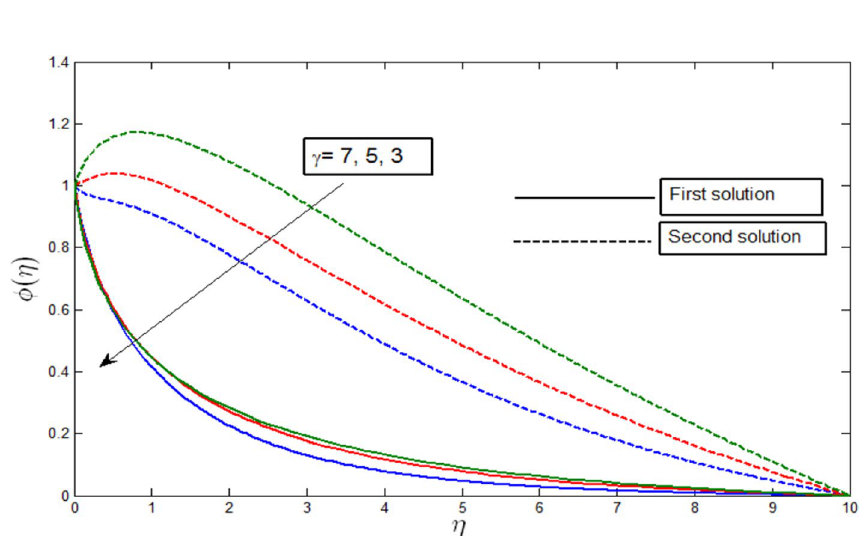
Figure 9. Concentration profile φ(η) for various γ when (cid:31) = − 4, Lb = 0.5, Le = 1, Pb = 0.5, Nr = 0.5, Rb = 0.6, A =